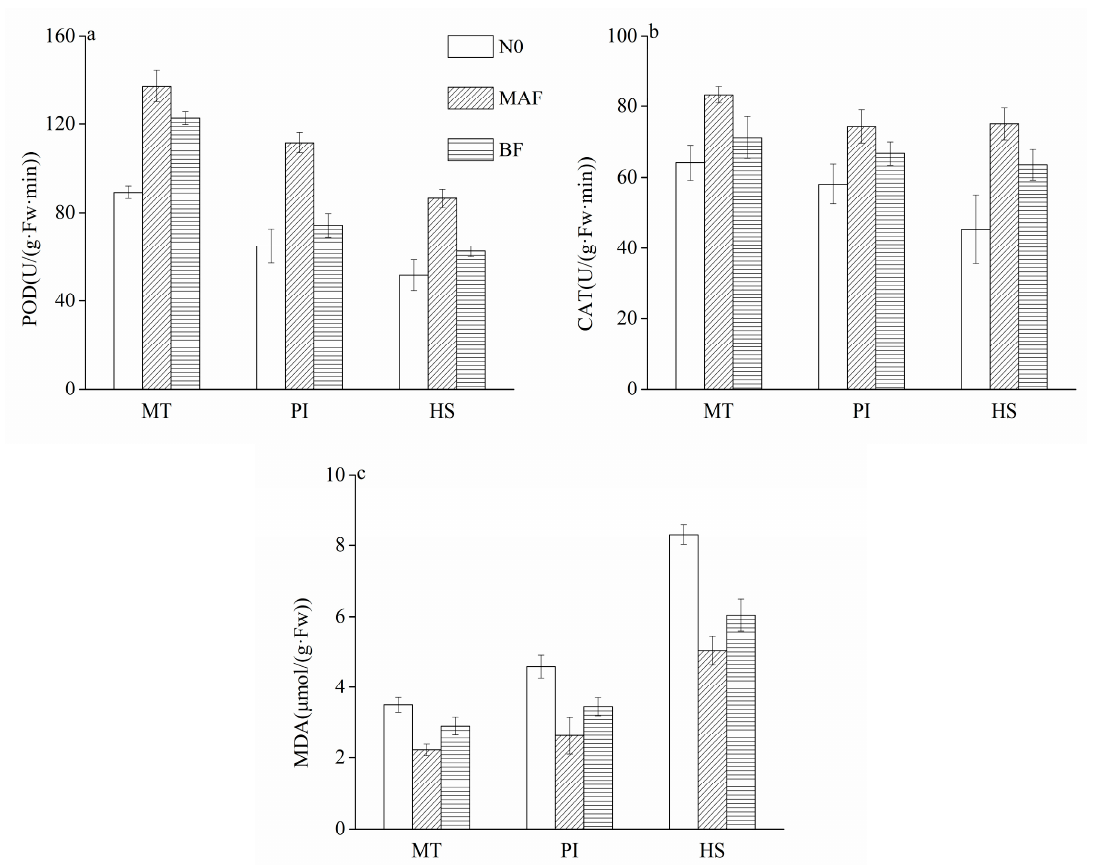
Figure 3. Effects of mechanical deep placement of nitrogen fertilizer on average for POD, CAT activity, and MDA content for both rice cultivars (2018 and 2019). ( a ): POD, ( b) : CAT, ( c) :